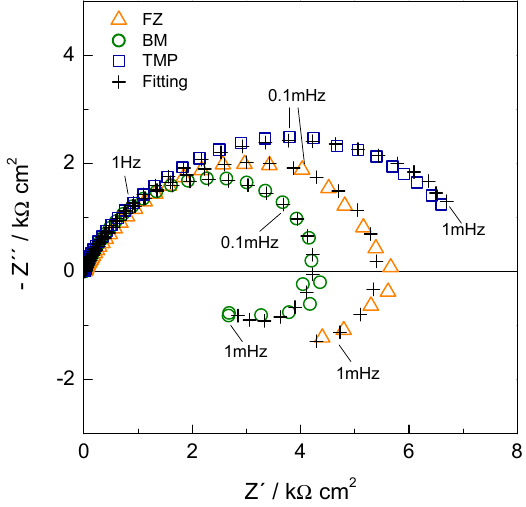
Figure 26. Nyquist plots for the fusion zone (FZ), base metal (BM), and thermo-mechanically processed (TMP) Fe-30Mn-5Al-6Cr-0.5C TWIP specimen in 3.5 wt.% NaCl solution at room temperature [193]. (Reproduced with permission from refs. [193]. Copyright (2020), Taylor & Francis).